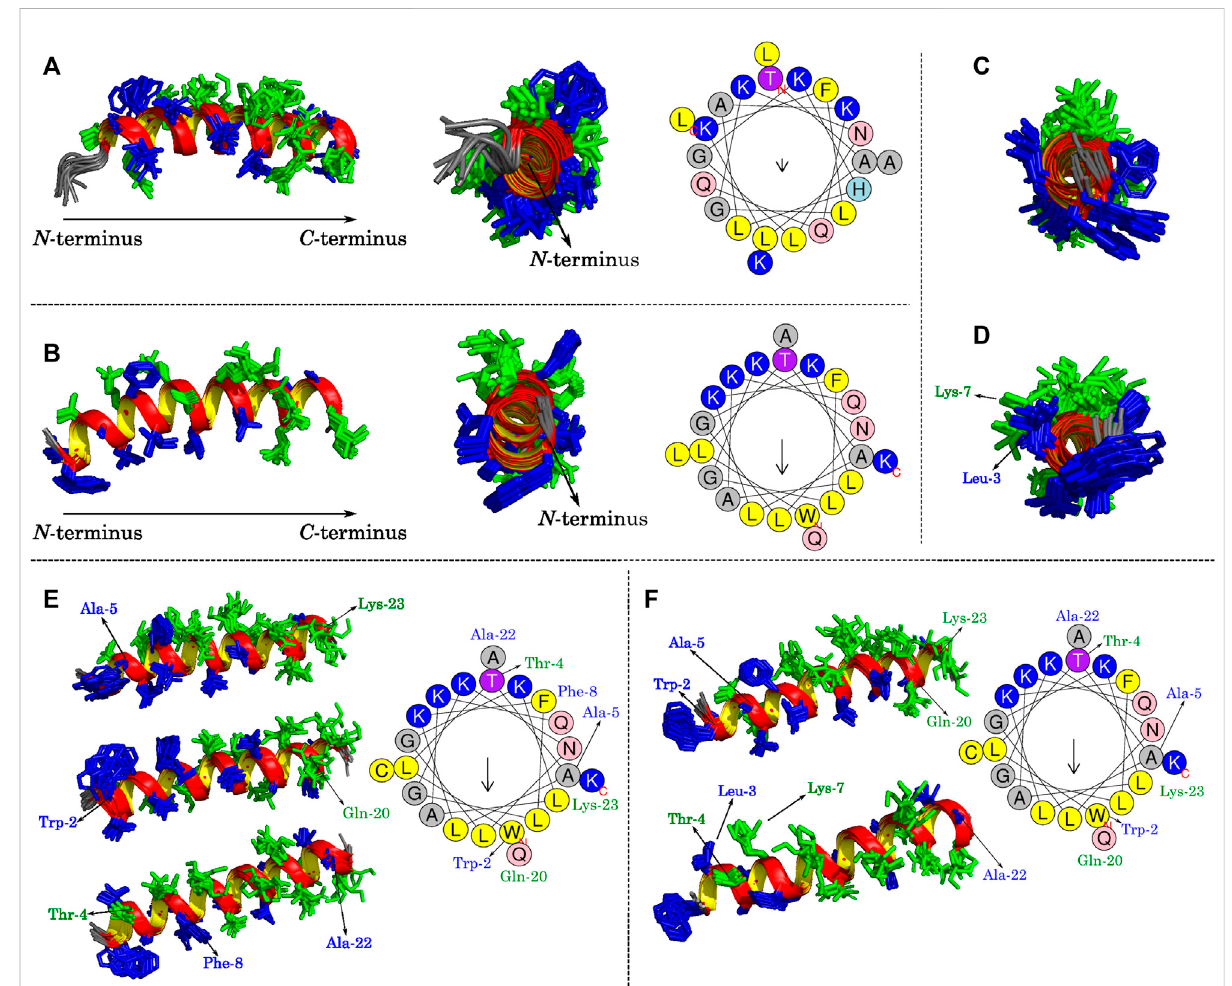
Lateral and frontal views of (A) LyeTx I (Santos et al., 2010) and (B) LyeTx I-b (Reis et al., 2018) helix structures with their respective Schiffer- Edmundson projections from HelixQuest. Frontal views of (C) LyeTx I-b cys and (D) LyeTx I-bPEG helices are shown and panels (E) and (F) explicitly show the residues involved in disrupting the hydrophobic and hydrophilic faces of LyeTx I-b cys and LyeTx I-bPEG, respectively, as veri fi ed by their respective Schiffer-Edmundson projections. In all helix plots, the hydrophobic residues are shown in dark blue and the hydrophilic ones in